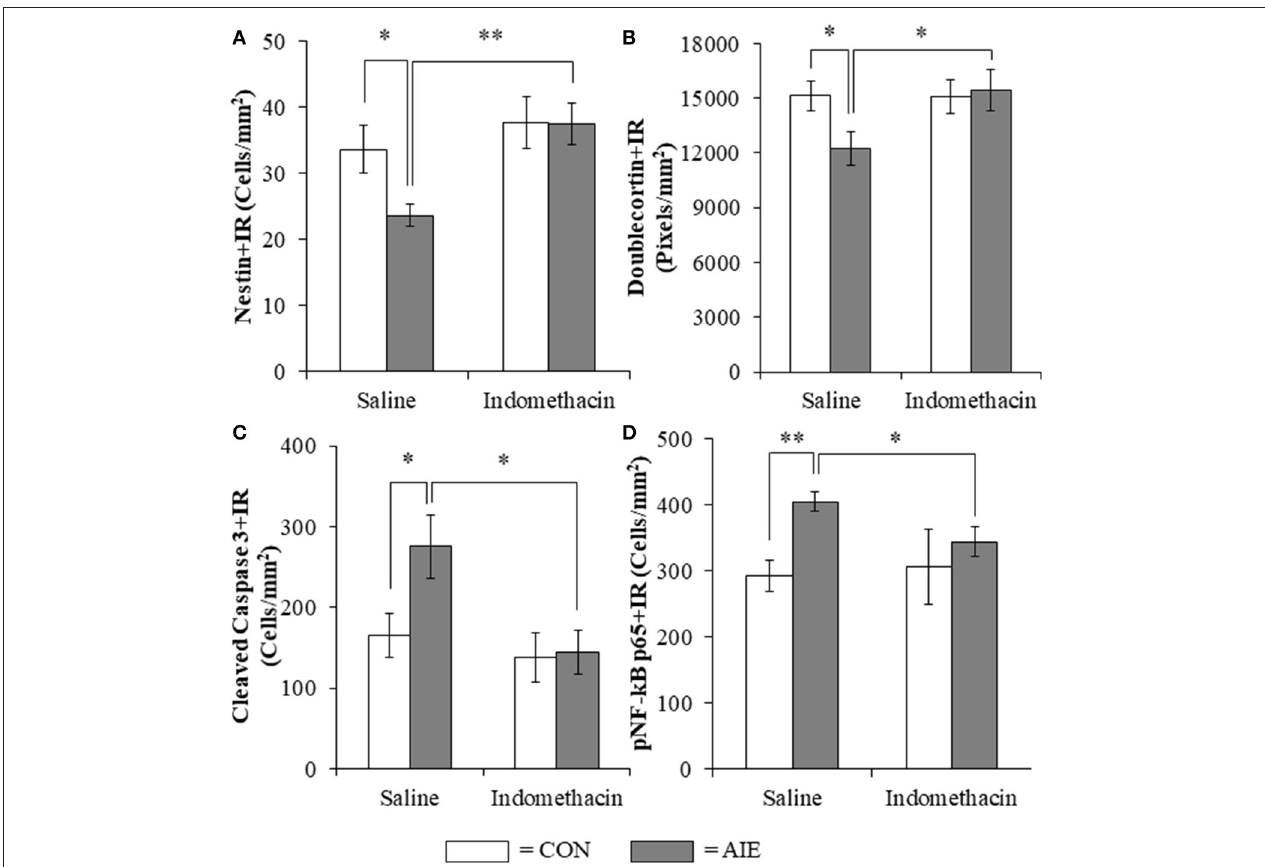
FIGURE 7 | Indomethacin treatment prevented the adolescent intermittent ethanol (AIE)-induced loss of neurogenesis markers, the increase of the cell death marker cleaved caspase 3, and phosphorylation of the proinflammatory transcription factor nuclear factor kappa-light-chain-enhancer of activated B cells p65 (phosphorylated [pNF- κ B p65]) in the hippocampal dentate gyrus. (A) Modified unbiased stereological assessment revealed a 30% ( ± 5%) reduction of the neural progenitor marker nestin in the hippocampal dentate gyrus of late adolescent (P56) AIE-treated animals, relative to CONs. Treatment with indomethacin prevented the AIE-induced loss of nestin + cells. (B) Quantification of doublecortin pixel density revealed a 21% ( ± 6%) reduction in the hippocampal dentate gyrus of AIE-treated animals, relative to CONs. Subjects in the AIE treatment group that received indomethacin treatment did not evidence the AIE-induced loss of doublecortin + IR, relative to AIE animals. (C) Modified unbiased stereological quantification revealed a 66% ( ± 24%) increase of the cell death marker cleaved caspase 3 in the hippocampal dentate gyrus of AIE-treated animals, relative to CONs. Subjects in the AIE treatment group that received indomethacin treatment did not evidence the observed increase of cleaved caspase 3 + IR cells, relative to AIE animals. (D) Modified unbiased stereological quantification of pNF- κ B p65 + IR cells revealed a 38% ( ± 5%) increase in the hippocampal dentate gyrus of AIE-treated animals, relative to CONs. Furthermore, subjects in the AIE treatment group that